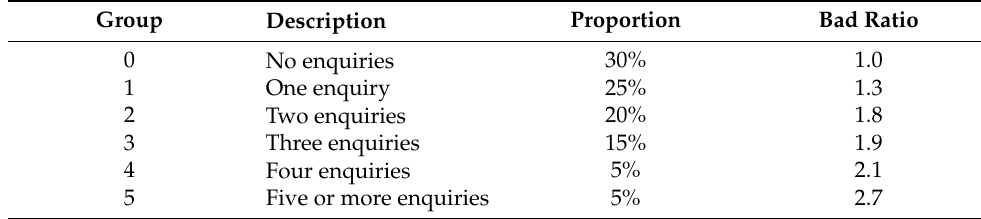
Table A1. Number of enquiries.